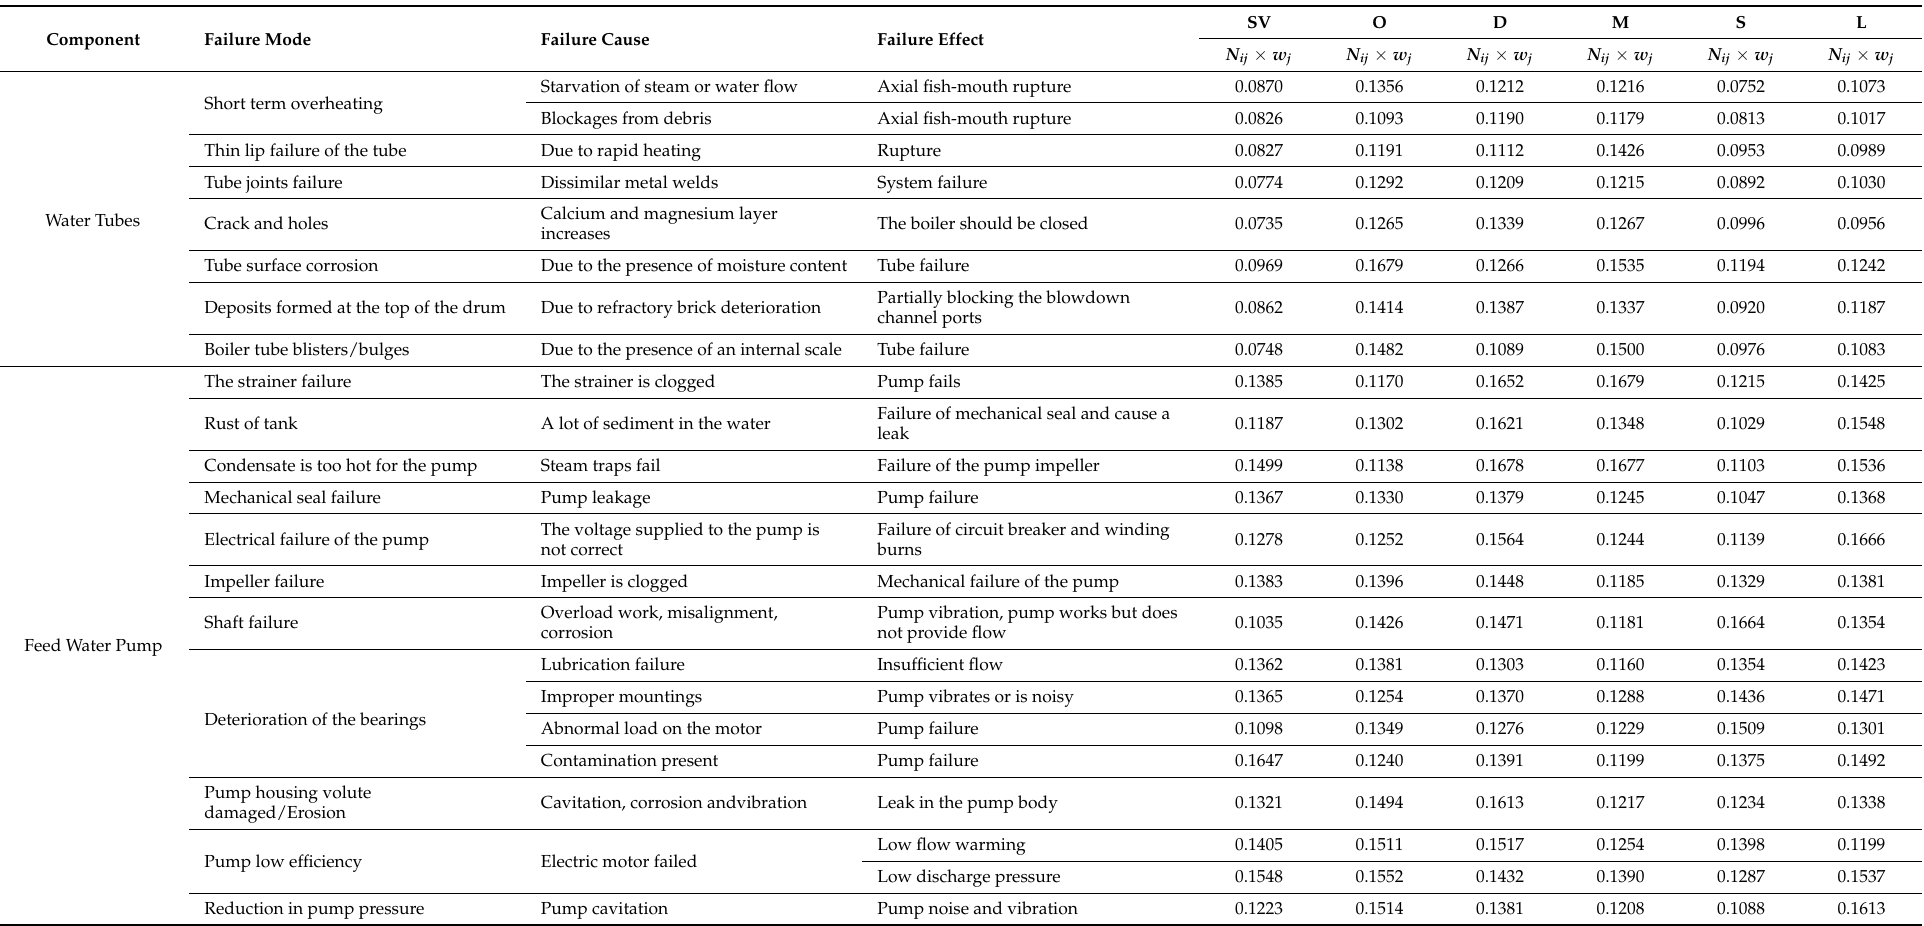
Table 11. Multiplication matrix of N ij and w j